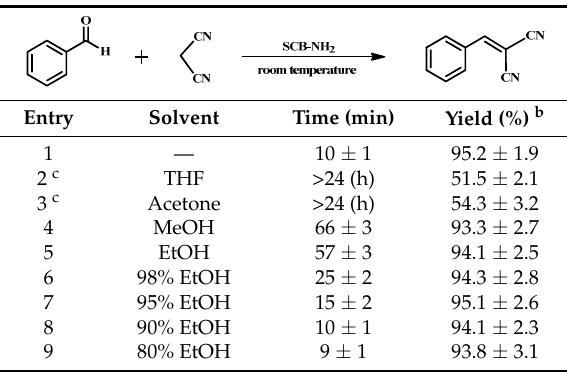
Table 3. The influence of the solvent a . Table 2. The influence of the catalyst dosage a